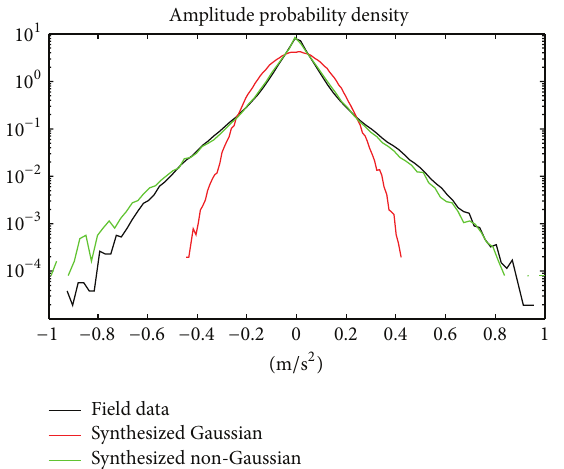
Figure 9: The PDF of the field data and synthesized Gaussian and non-Gaussian signal.